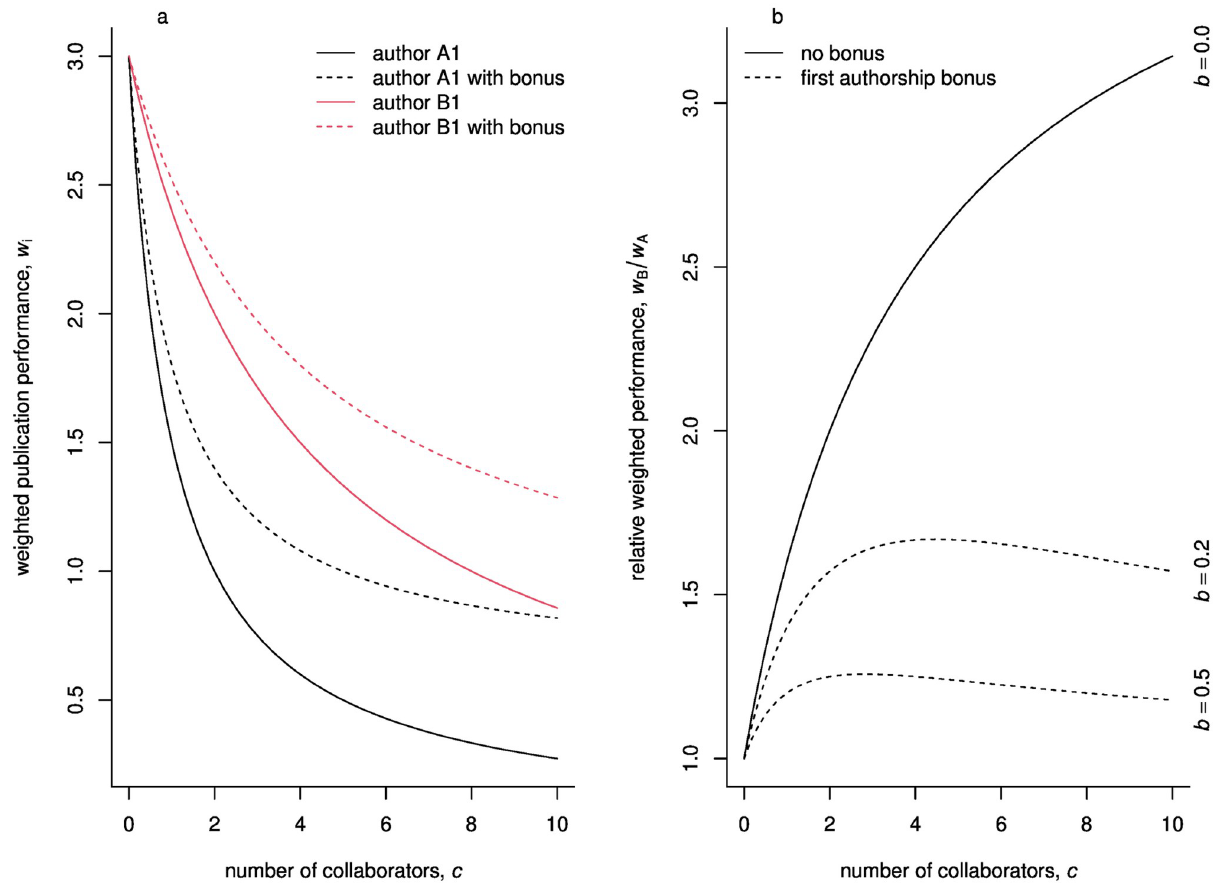
Fig 2. Publication performance when authors collaborate with people from outside of their groups. Weighted publication performance of authors A 1 and B 1 (a). Weighted publication performance of author B 1 relative to that of author A 1 (b). The weighted publication performance is calculated by taking into account the number of coauthors. During this calculation first authorship can be rewarded by a bonus, b . If b = 0, then each coauthors receive the same weight for a given publication. On the other hand, if b > 0, the weight of the first author is higher than that of the coauthors, i.e. the first author of a paper is rewarded. On subpanel (a) b = 0.2, on (b) b is given on the right margin.